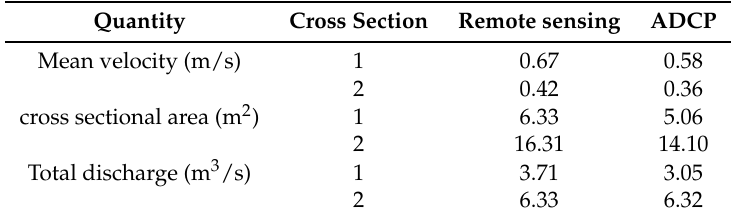
Table 3. Hydraulic quantities calculated from remotely sensed data and field-based ADCP measurements for two cross sections on the Blue